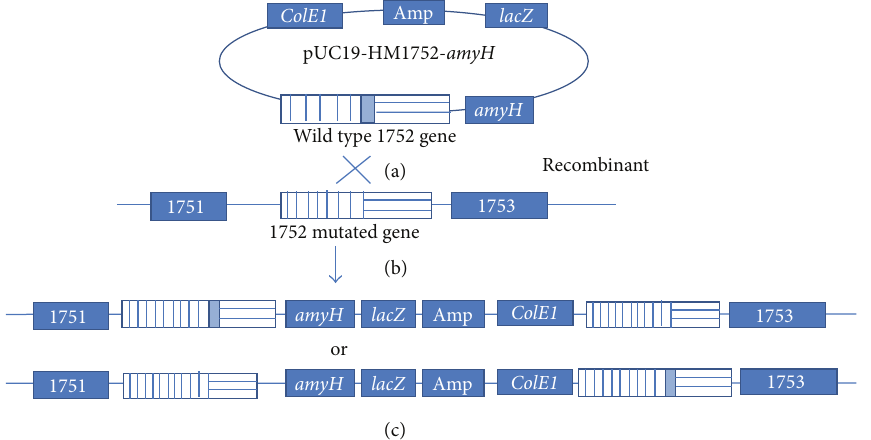
Figure 6: The possible integration position of exogenous DNA in the genome of transformants conferring amylase activity. Strain J7-2-1 was transformed with pUC19-HM1752- amyH and the schematic diagram shows the possible crossover event between the plasmid and J7-2-1 genome. (a) Plasmid pUC19-HM1752- amyH . (b) J7-2-1 genome with the mutated 1752 gene. (c) The possible integration position of exogenous DNA on the genome of the transformants conferring amylase